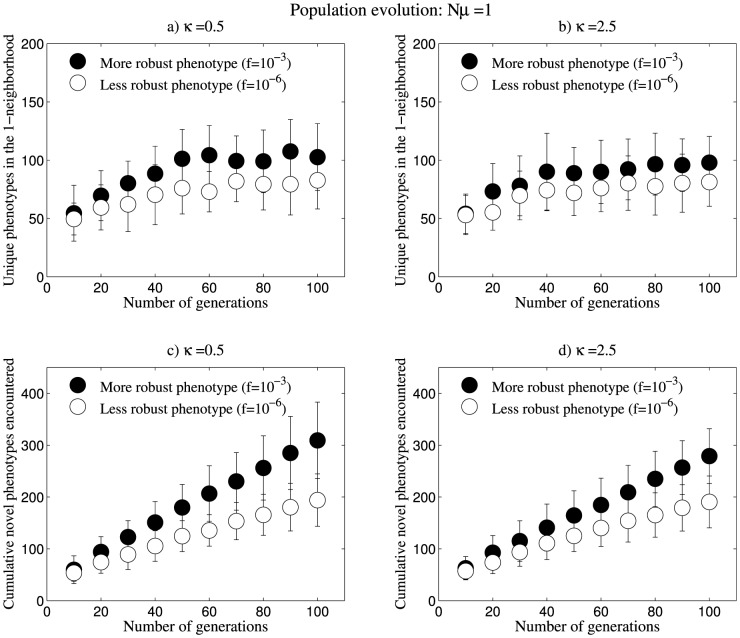
Populations evolving at the rate Nµ = 1.Data shown are for populations of N = 10 identical sequences for each of the 40 inversely folded sequences from the two phenotypes. These sequences are evolving at the rate of µ = 0.1 (one nucleotide per 10 sequences per generation). (a), (b) In populations evolving at the rate of Nµ = 1, the number of unique phenotypes encountered by the more robust phenotype increases at a faster pace compared to the less robust phenotype. The more robust phenotype can access a structurally more diverse 1-neighbourhood compared to the less robust phenotype by the end of 100th generation. (c), (d) More robust phenotypes can access encounter more cumulative novel phenotypes during evolution. We observe that even for low rates of evolution, such as Nµ = 1, more robust phenotypes can access greater variation. The neutral networks of the phenotypes are weighted using κ = 0.5 and 2.5. We observe that both unique phenotypes in 1-neighborhood and cumulative novel phenotypes decrease as we increase the value of κ. We did not observe significant results for κ = 10.